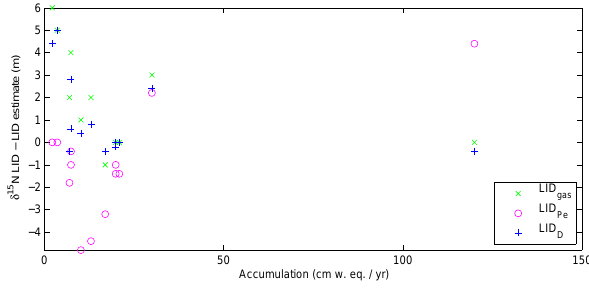
Fig. 10. Distance between the LID estimated with an observed slope break on δ 15 N ( δ 15 N LID) and the LID estimated with: reference gas measurements (CO 2 and/or CH 4 , LID gas , green × ), an up- per threshold on the P´eclet number (LID Pe , purple o) and a lower threshold on the diffusivity (LID D , blue